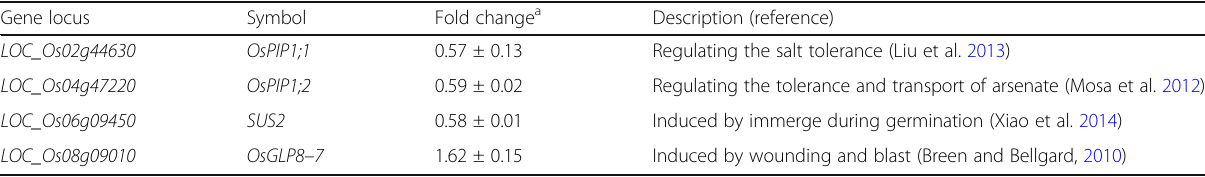
Table 1 The differentially expressed proteins (DEPs) related to the stress response Gene